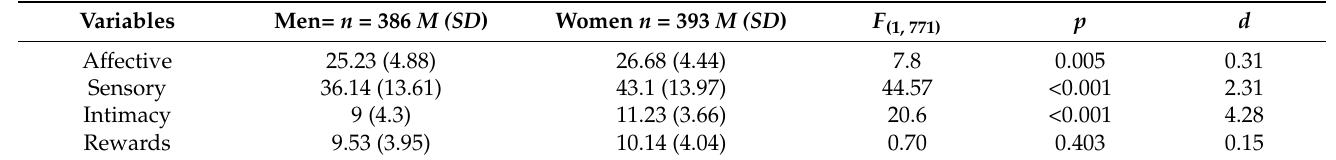
Table 4. Effects of sex on subjective orgasm experience in gay